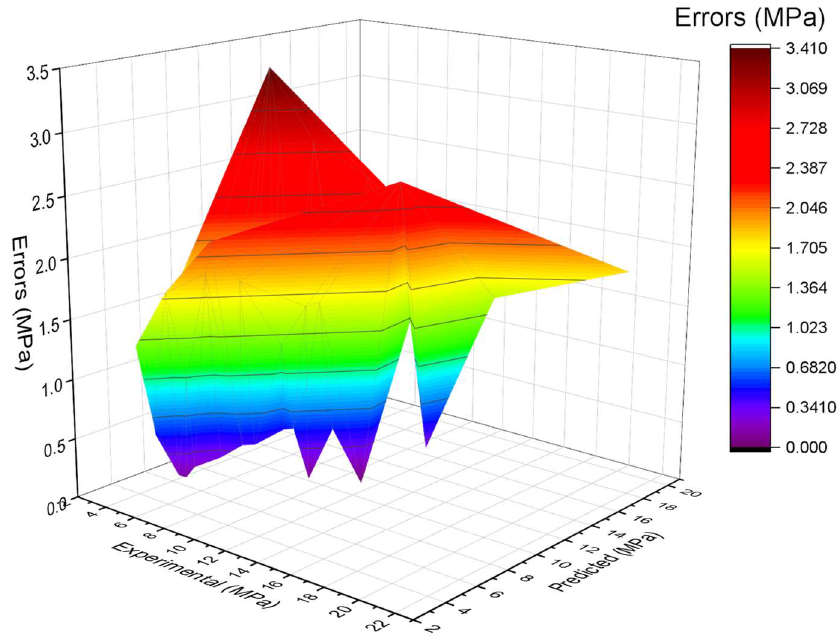
Figure 7. Estimated bagging and experimental values, with errors.